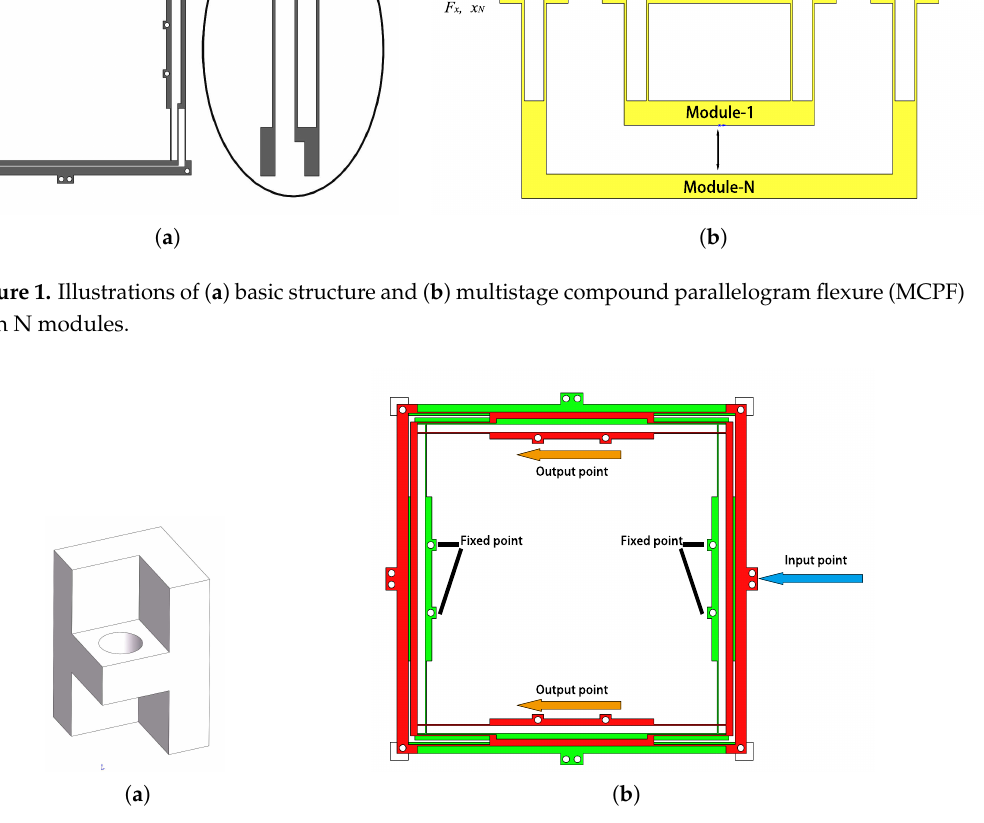
Figure 2. Illustrations of ( a ) fixture and ( b ) assembled stroke structure (top